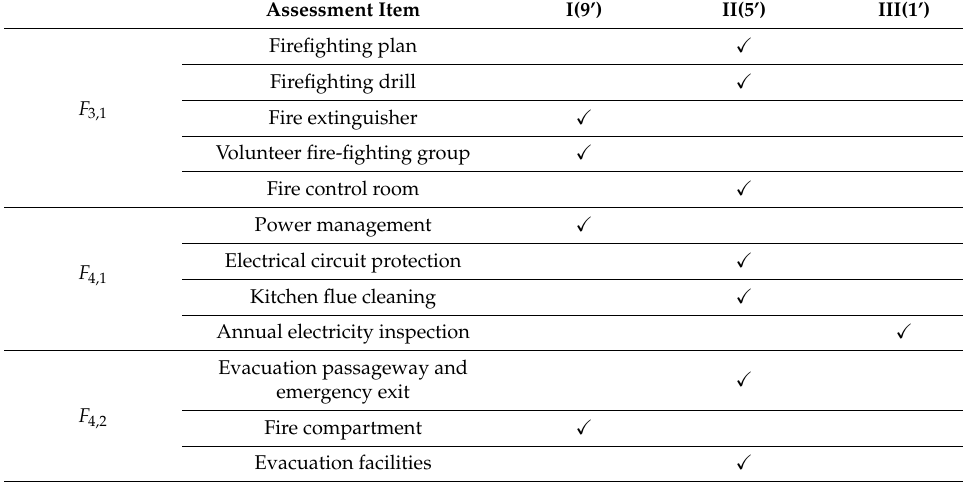
Table 7. Scoring details of factors F 3,1 , F 4,1 and F 4,2 in the annual fire management report.